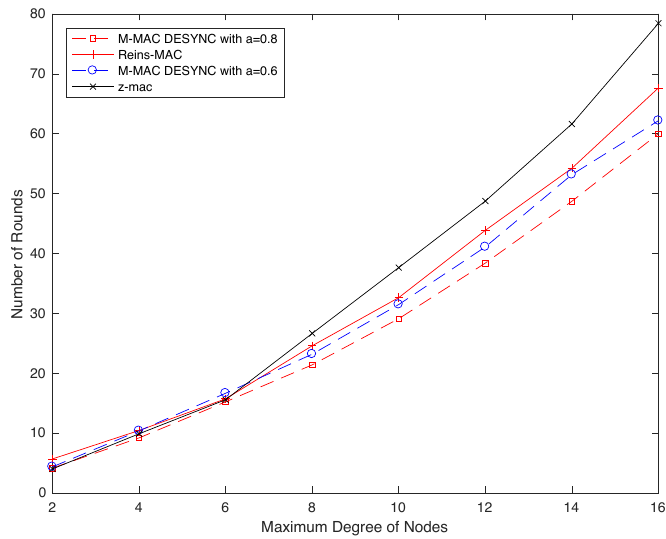
Figure 9. The average number of convergence rounds in different size of maximum degree of nodes in the network.